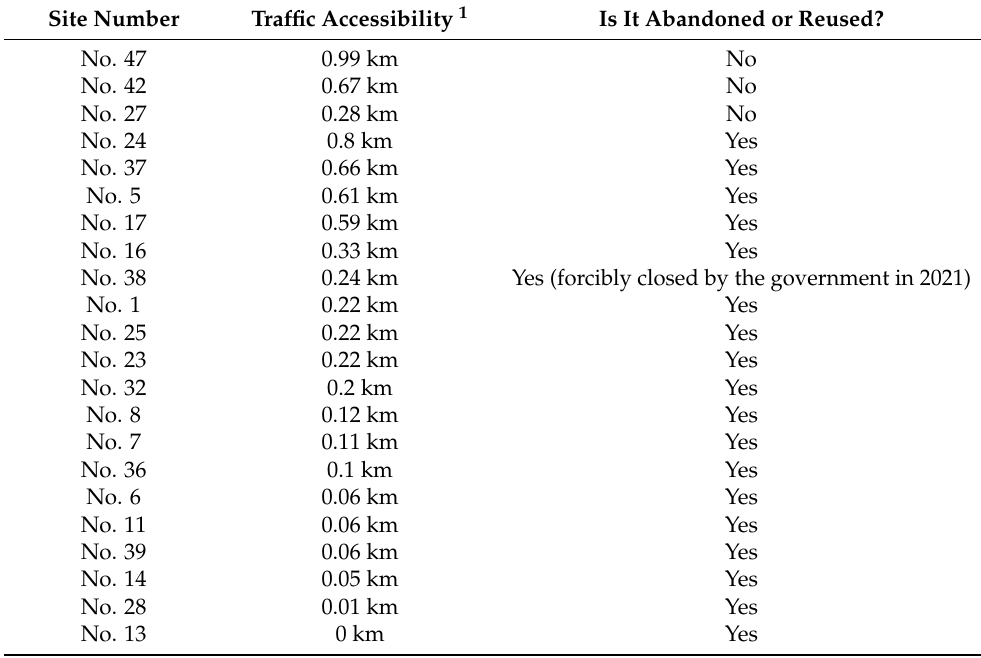
Table 2. Statistics of accessibility analysis of capital-intensive industrial heritage.